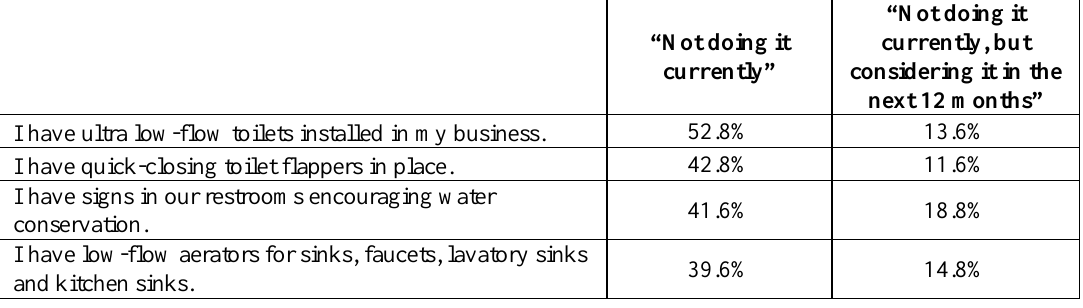
“Not doing it “Not doing it currently, but considering it in the currently” next 12